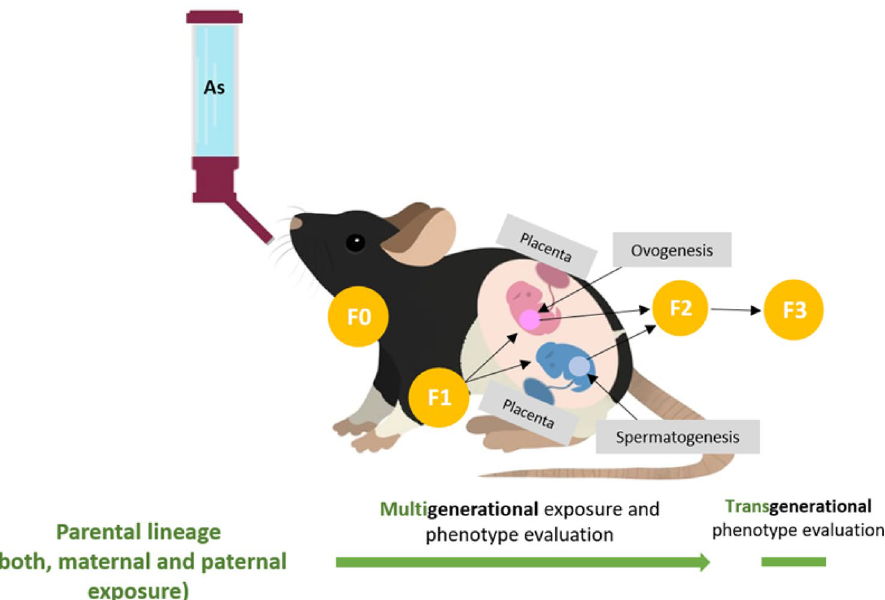
Figure 7. Illustration of the As exposure through drinking water in every generation. F0 parental direct exposure, F1 offspring indirect exposure in utero and trough being breastfed until weaning in 21st day,